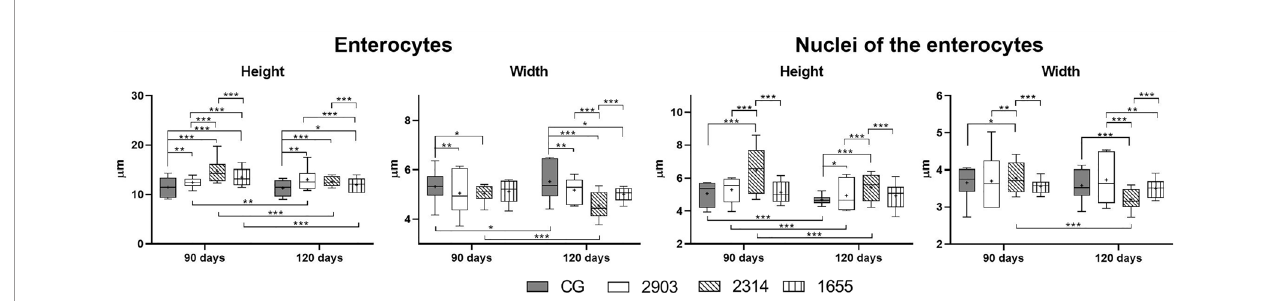
FIGURE 6 | Morphometry of ileum enterocytes from hamsters infected with different L. ( V.) braziliensis strains at 90 or 120 days of infection (μm). Data represented in box plots (median with 25 to 75 percentile), whiskers (2.5 to 97.5 percentile), and mean (+) ( n = 6). * p < 0.05; ** p < 0.01; *** p < 0.001. CG, control group. 2903: group infected with MHOM/BR/1975/M2903. 2314: group infected with MHOM/BR/2003/2314. 1655: group infected